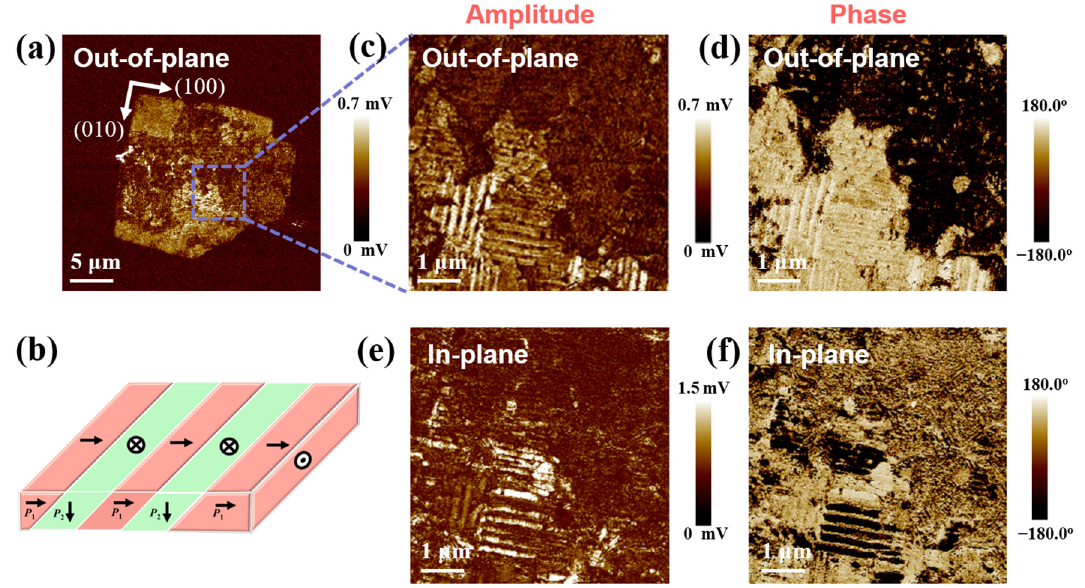
Figure 6. Domain structures of BaTiO 3 plate. ( a ) Out-of-plane PFM image of the whole plate. ( b ) 3D schematic domain structure. Out-of-plane ( c ) amplitude and ( d ) phase image, in-plane ( e ) amplitude, and ( f ) phase image of a 6 µm × 6 µm square region.